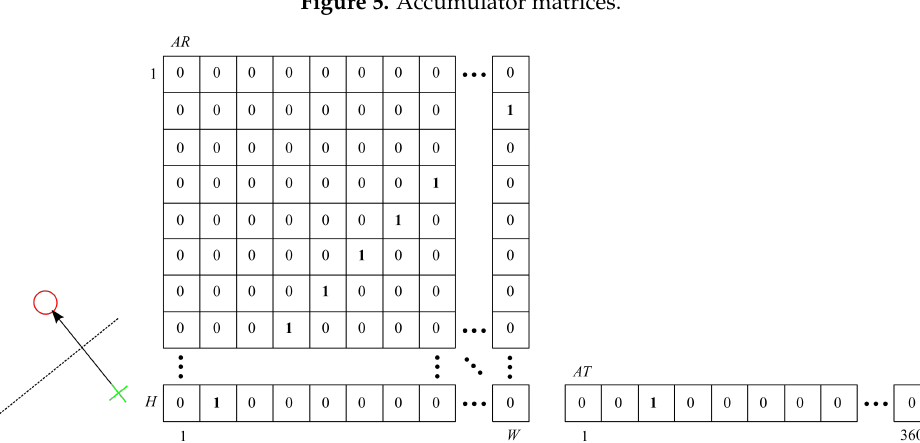
Figure 5. Accumulator matrices.